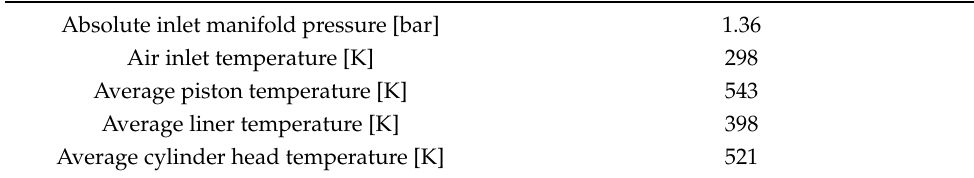
Table 3. Initial and boundary conditions for CFD